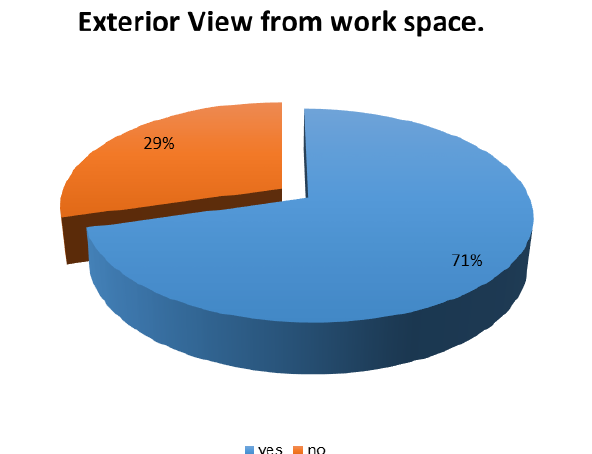
Figure 4. Exterior nature view from office space as a source of positive distraction.